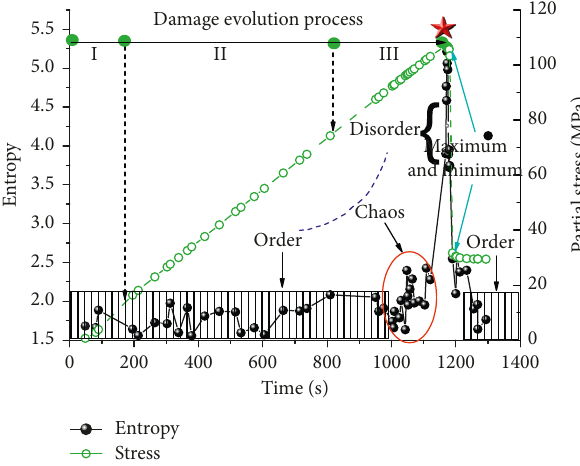
Figure 18: The variation law of sz-22 stress time entropy